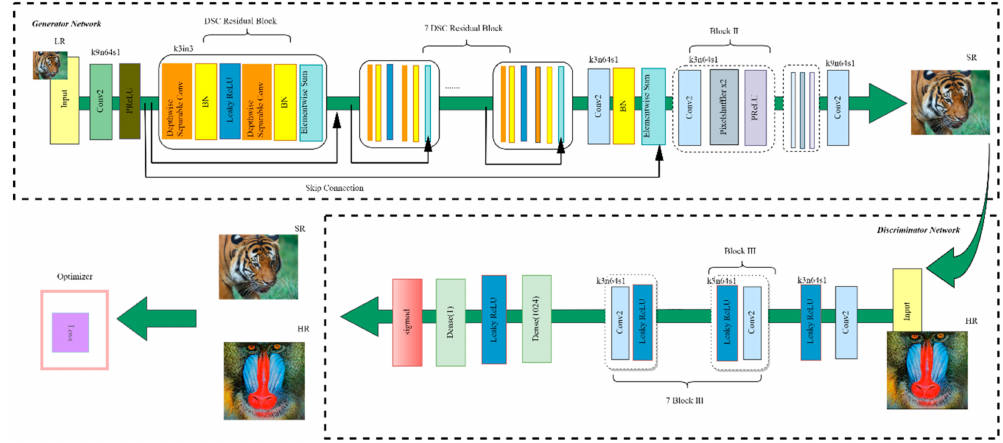
Figure 2. An overview of our DSCSRGAN. Kernel size(k), number of maps(n), in_channels(in), and stride(s) are indicated for each convolutional layer. The same color represents the same structure. (Best viewed in